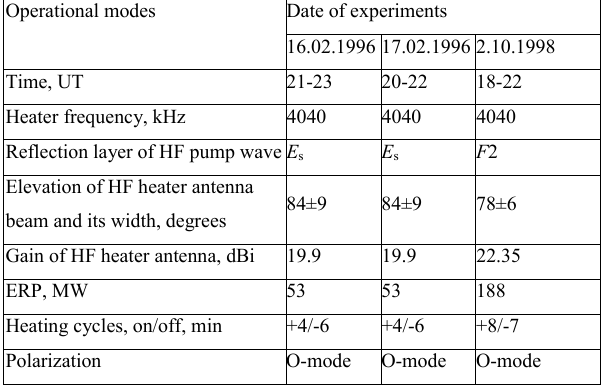
Table 1. Operational modes of the EISCAT HF heating facility during